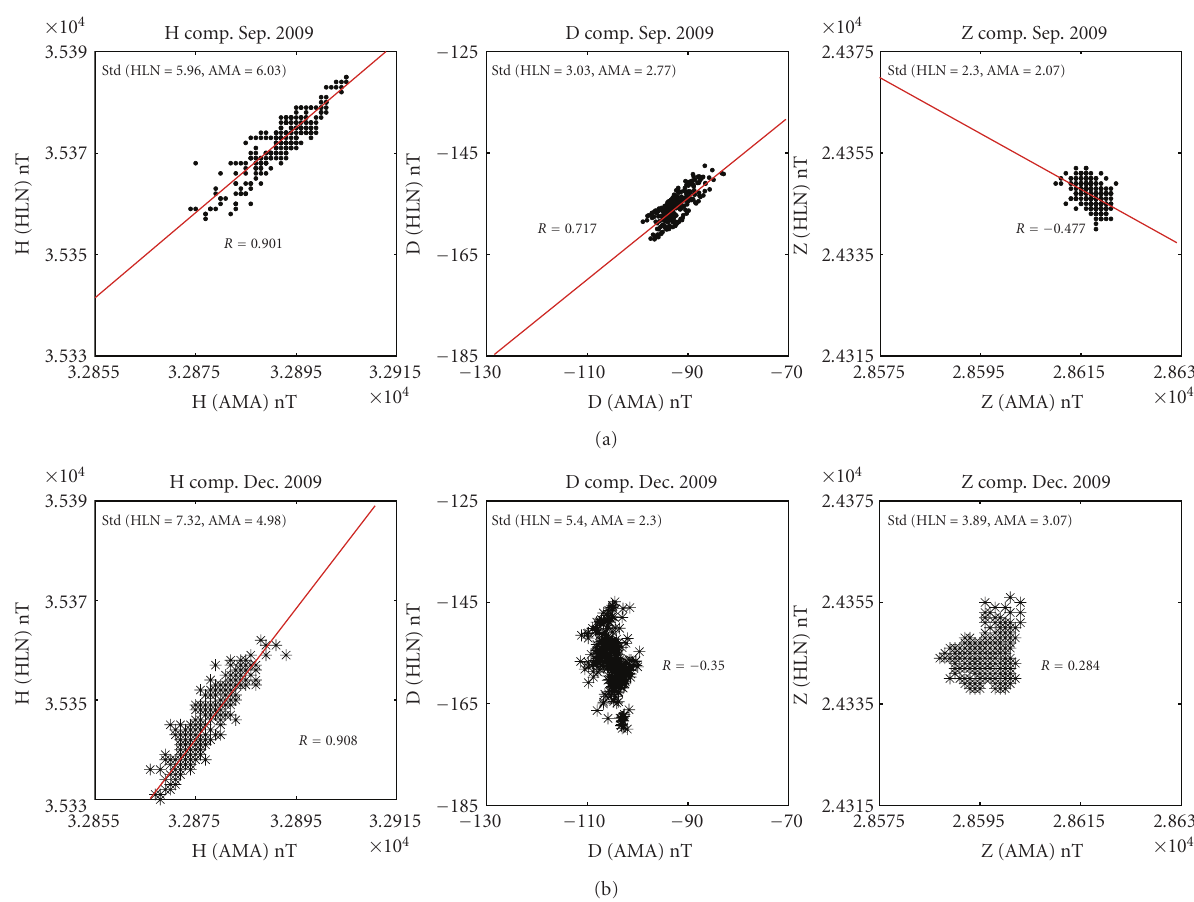
Figure 6: The correlation plots of the geomagnetic data acquired at the HLN and AMA stations in September (a) and December 2009 (b) with the standard deviation value for each component during the two months (nighttime data 1100–2100